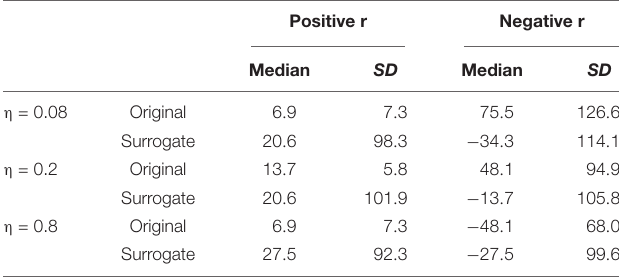
TABLE 1 | Medians and standard deviations (across speakers) of the lag (in ms) at which the highest positive and negative correlations are found between MBEAM and MFCC functions.